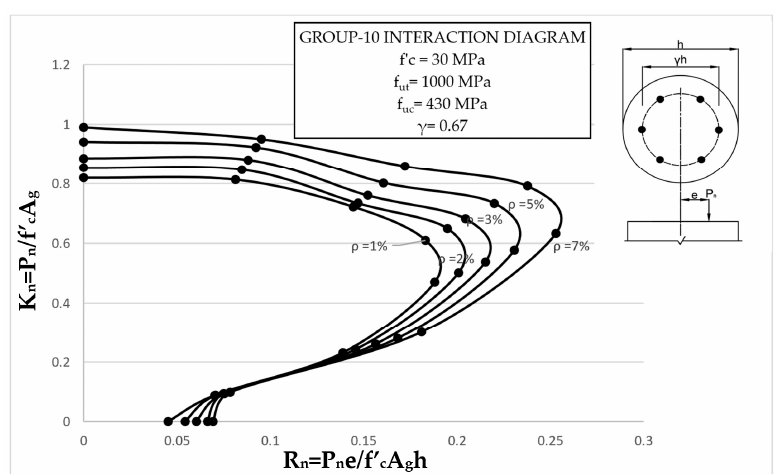
Figure 22. Group 10 interaction diagram.